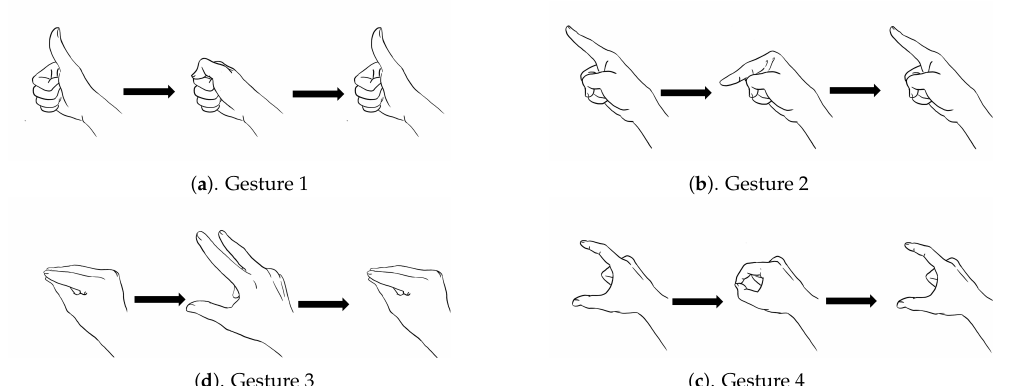
Figure 8. The four finger gesture classes considered in this study.